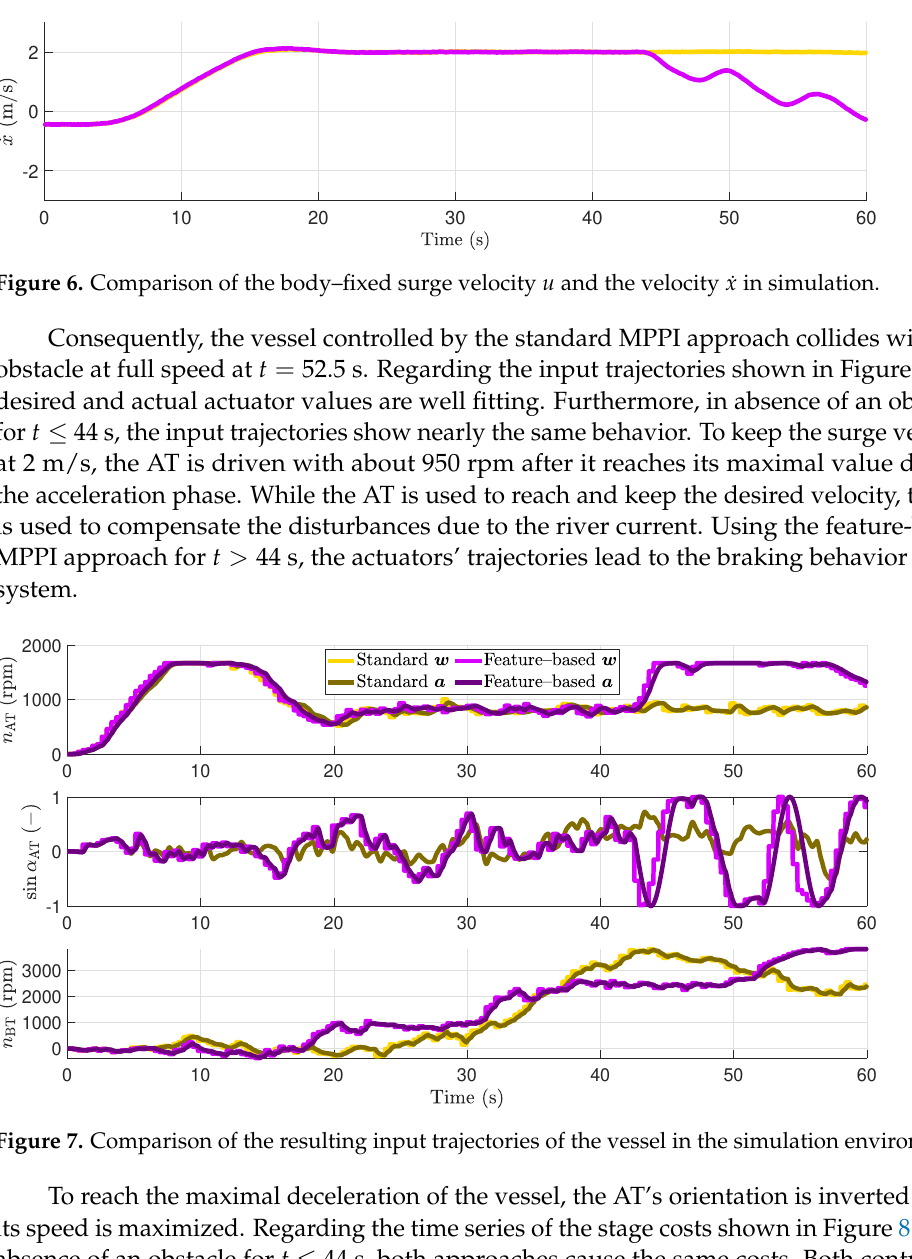
Figure 7. Comparison of the resulting input trajectories of the vessel in the simulation environment. To reach the maximal deceleration of the vessel, the AT’s orientation is inverted while its speed is maximized. Regarding the time series of the stage costs shown in Figure 8 in the absence of an obstacle for t ≤ 44 s, both approaches cause the same costs. Both controllers find inputs leading to decreasing costs. After the obstacle is detected, the feature-based control approach applies the learned inputs corresponding to the defined feature. These inputs lead to increasing cost due to the decelerating surge velocity; however, in